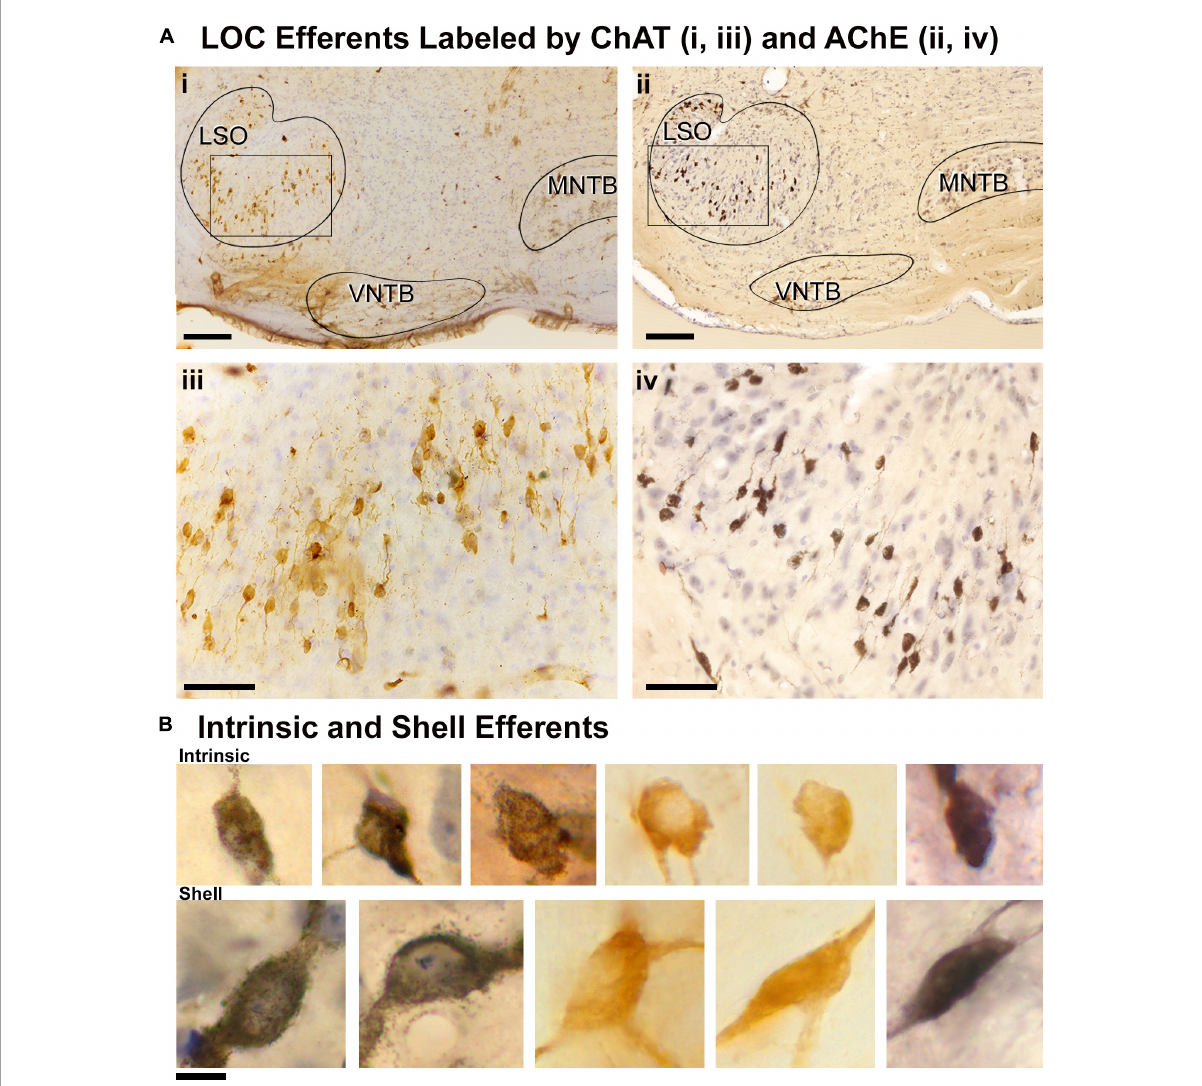
FIGURE3 Labeled cholinergic LOC efferent neurons. LOC neurons were labeled using cholinergic markers, ChAT and AChE, and counterstained with CV. (Ai) Photomicrograph (10x objective) of the superior olivary complex (SOC) region labeled by ChAT immunostaining. (ii) Photomicrograph (10x objective) of the SOC region labeled by AChE staining. (iii,iv) Higher magnification micrographs (40x objective) of inset (i,ii) , showing the ChAT and AChE labeled LOC neurons contained within the LSO, respectively. Note the similarity of ChAT and AChE labeling. (B) Photomicrographs (100x objective) showing the cholinergic LOC neurons labeled from either ChAT or AChE staining. The intrinsic neurons (top row) feature fusiform somata and were distributed throughout the core of the LSO nucleus. The shell neurons (bottom row) were larger and more globular in shape. LSO, lateral superior olive; VNTB, ventral nucleus of the trapezoid body; MNTB, medial nucleus of the trapezoid body. Scale bar equals 250 µ m (Ai,ii) , 50 µ m (Aiii,iv) , 25 µ m (B)